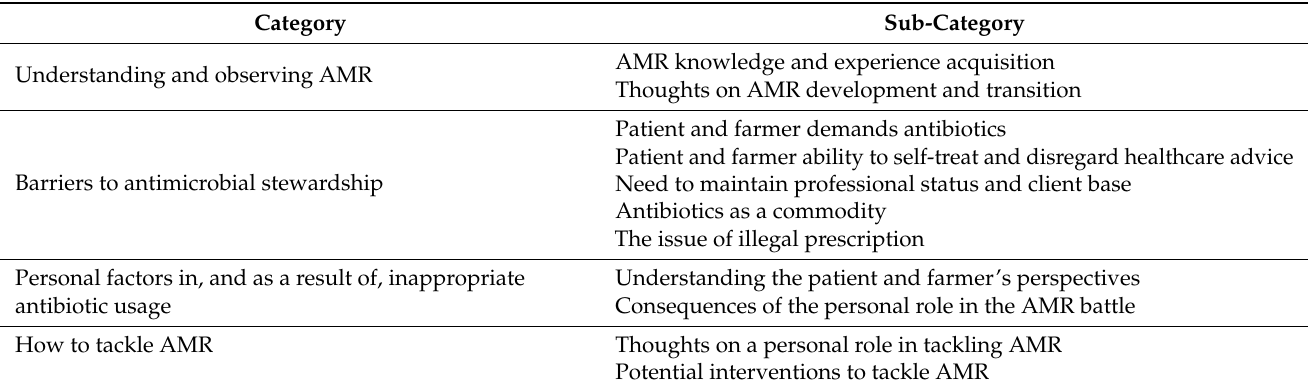
Table 2. Categories and sub-categories of content